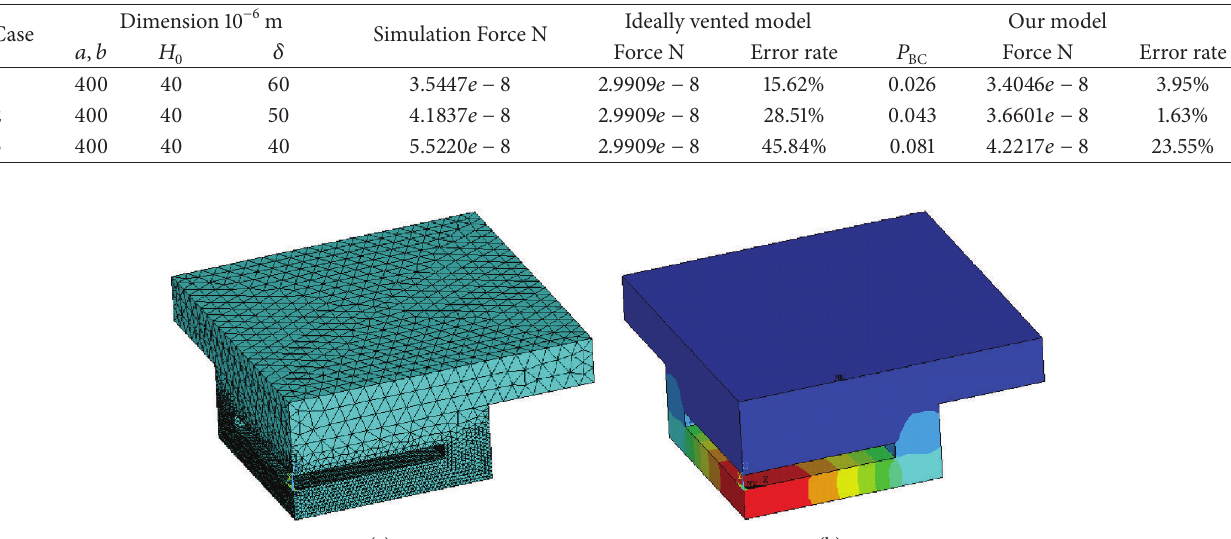
Table 1: Comparison of squeeze film damping between analytical models and simulation results in normal motion.